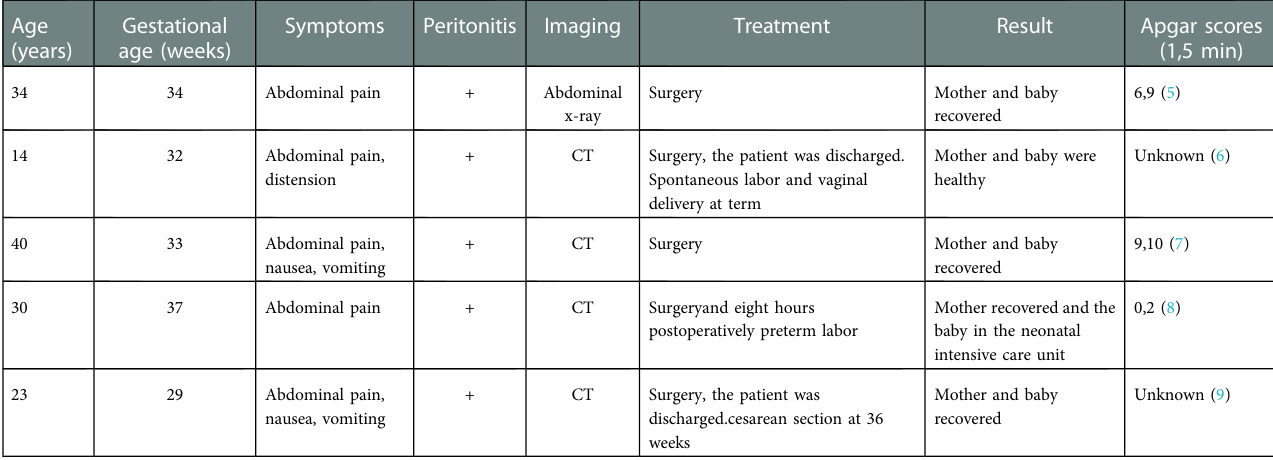
TABLE 1 Cases of Meckel ’ s diverticulum in the third trimester of pregnancy.